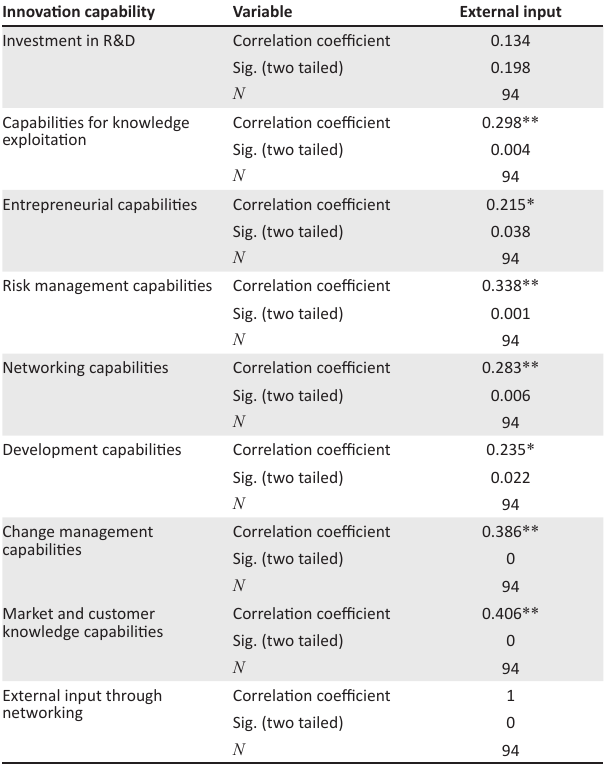
TABLE 3: Spearman’s correlation coefficient innovation capabilities and external input. Innovation capability